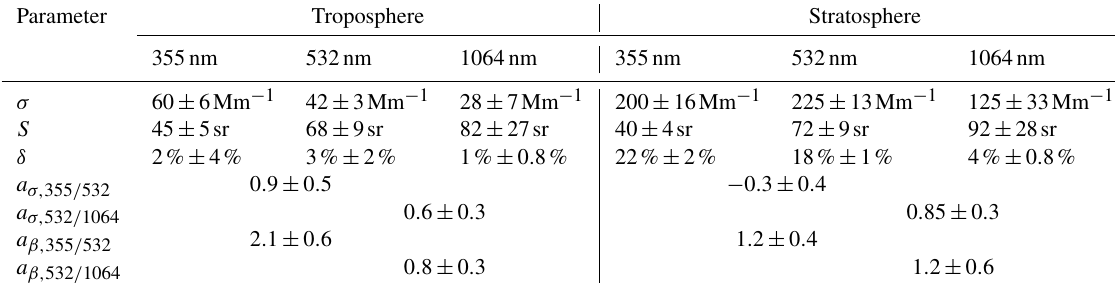
Table 1. Optical properties of smoke aerosol in the tropospheric layer (5–6.5km) and stratospheric smoke layer (15–16km). Layer-mean values of the particle extinction coefficient σ , lidar ratio S , particle linear depolarization ratio δ , and backscatter-related and extinction-related for the wavelength range from λ 1 to λ 2 are given. The Ångström exponents are directly computed and a β,λ Ångström exponents a σ,λ 1 /λ 2 1 /λ 2 from the particle backscatter and extinction values in this table. The listed layer-mean values (and retrieval uncertainties) are based on all available observations (with all three lidars) taken in the night of 22 August 2017. Parameter Troposphere Stratosphere 355nm 532nm 1064nm